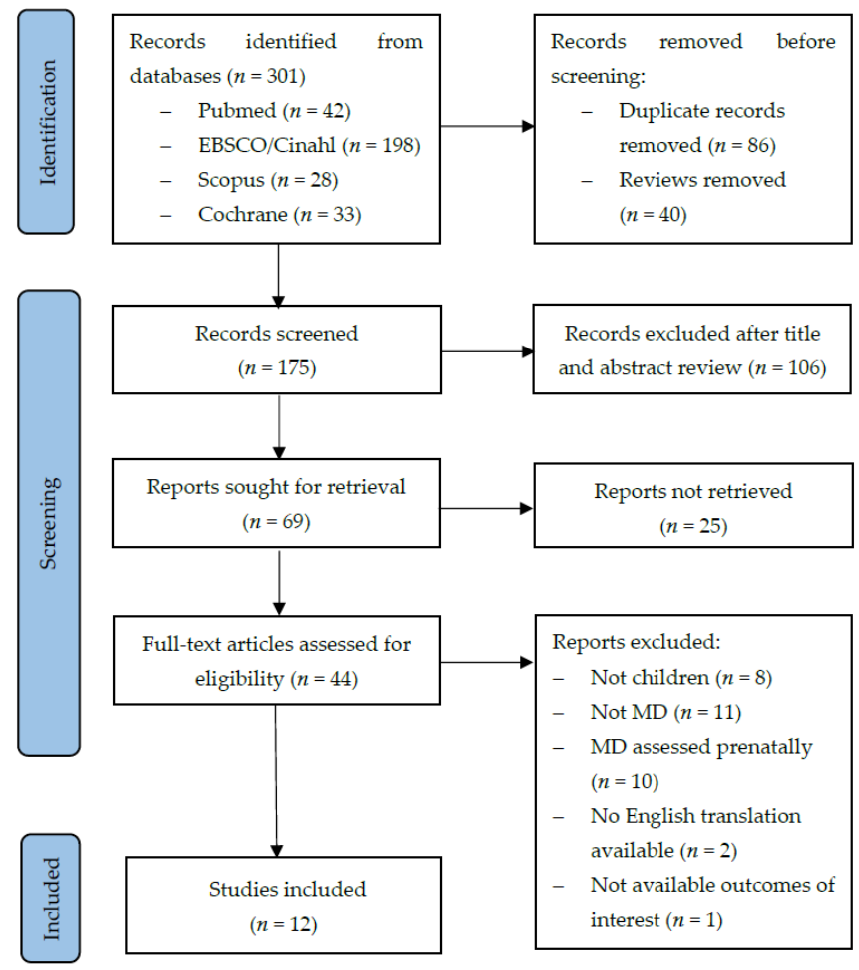
Figure 1. PRISMA diagram for study selection process.